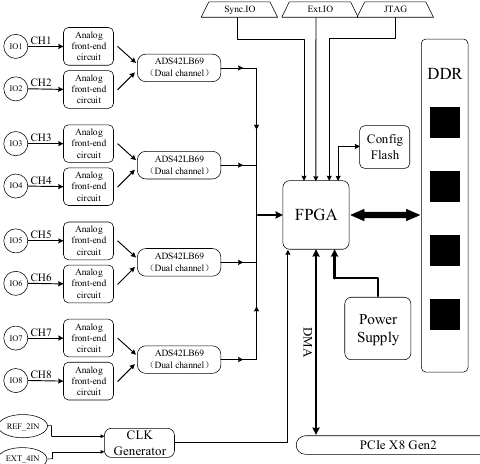
Figure 2. The structure of multi-channel data acquisition card.